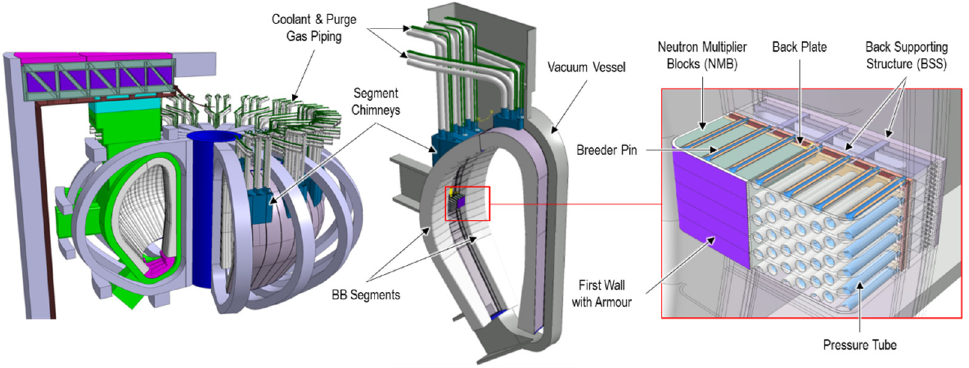
Figure 1. HCPB BB concept within the DEMO tokamak.